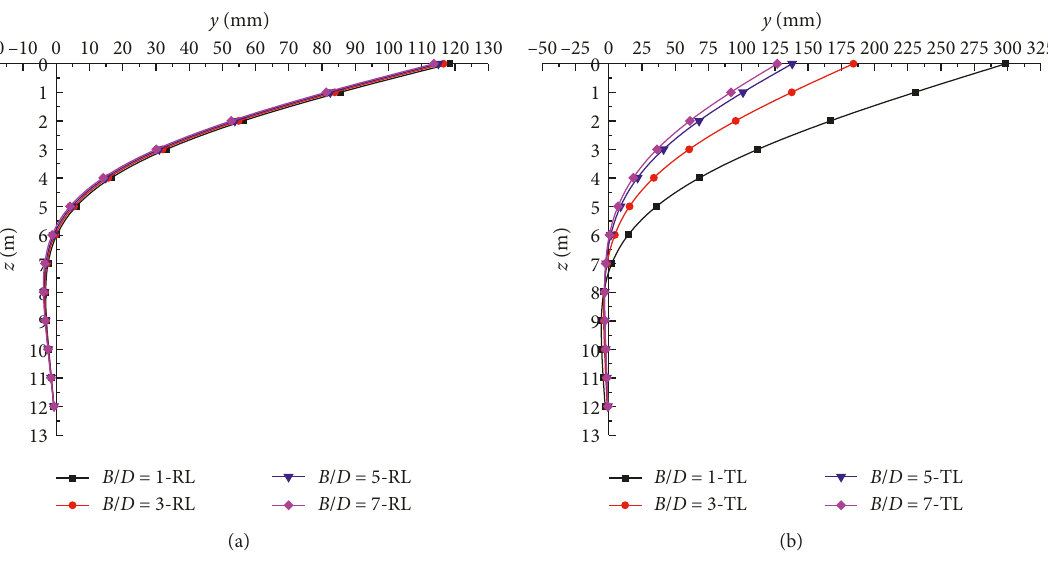
0 (cid:31) 1000kN. (a) Reverse